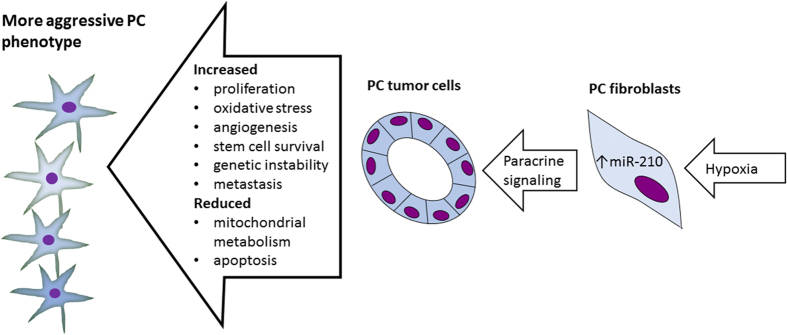
Under hypoxia, fibroblasts are induced to senescence and a cancer associated fibroblast (CAF) phenotype.These CAFs can secrete miR-210, which induces malignant transformation to the prostate cancer (PC) cells, yielding a more malignant phenotype mediating a poorer prognosis. Figure based on references253235. Abbrevations: EMT = endothelial mesenchymal transformation, PC = Prostate cancer.